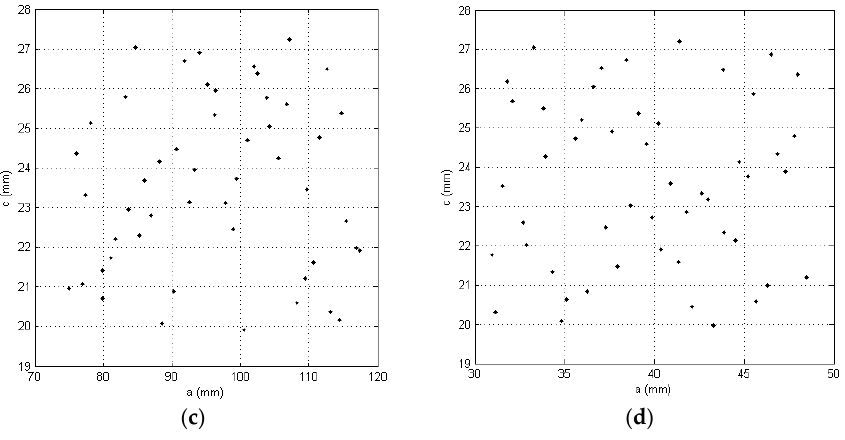
Figure 4. Parameter sampling for coupling beam metal dampers: ( a ) SP1; ( b ) SP2; ( c ) SP3; and ( d ) SP4.